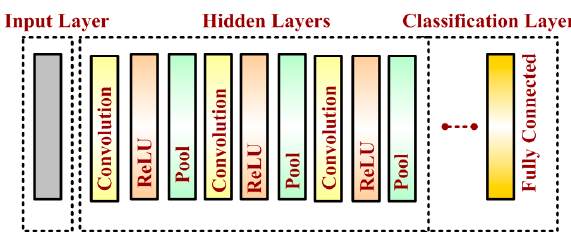
Figure 1. Typical convolutional neural network architecture.